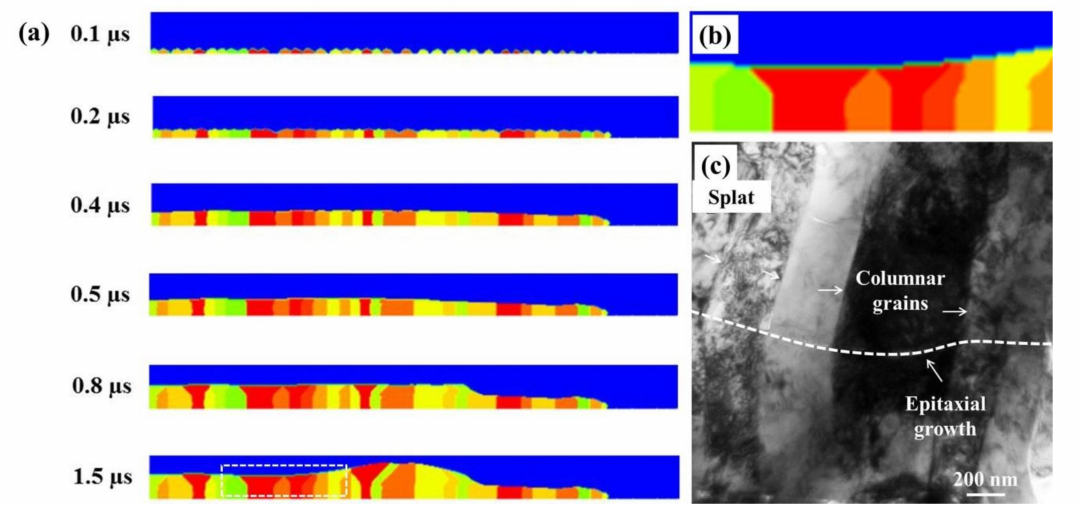
Figure 11. ( a ) Growth behavior of columnar grains of two refinement droplets after impacting on a substrate at 518 m / s; ( b ) Simulation results of columnar grains; ( c ) Bright Field (BF) cross-sectional TEM images of columnar